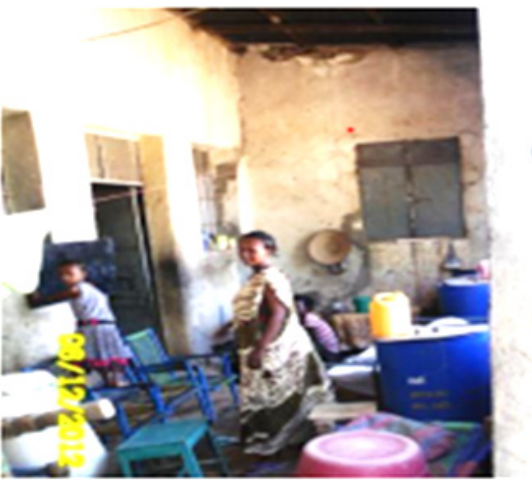
Figure 13. High internal spaces.